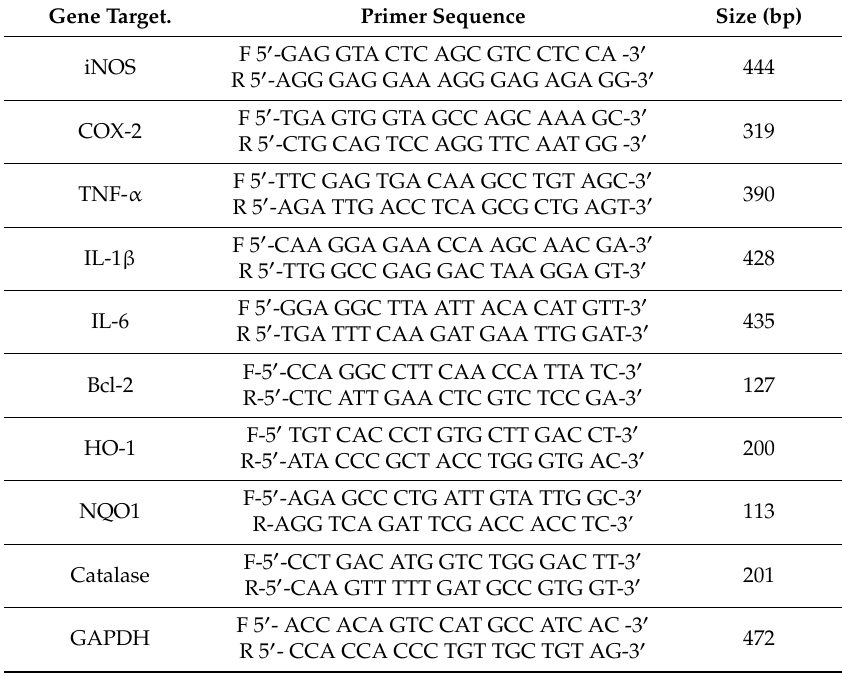
Table 1. The list of PCR primers employed in the present study. Gene